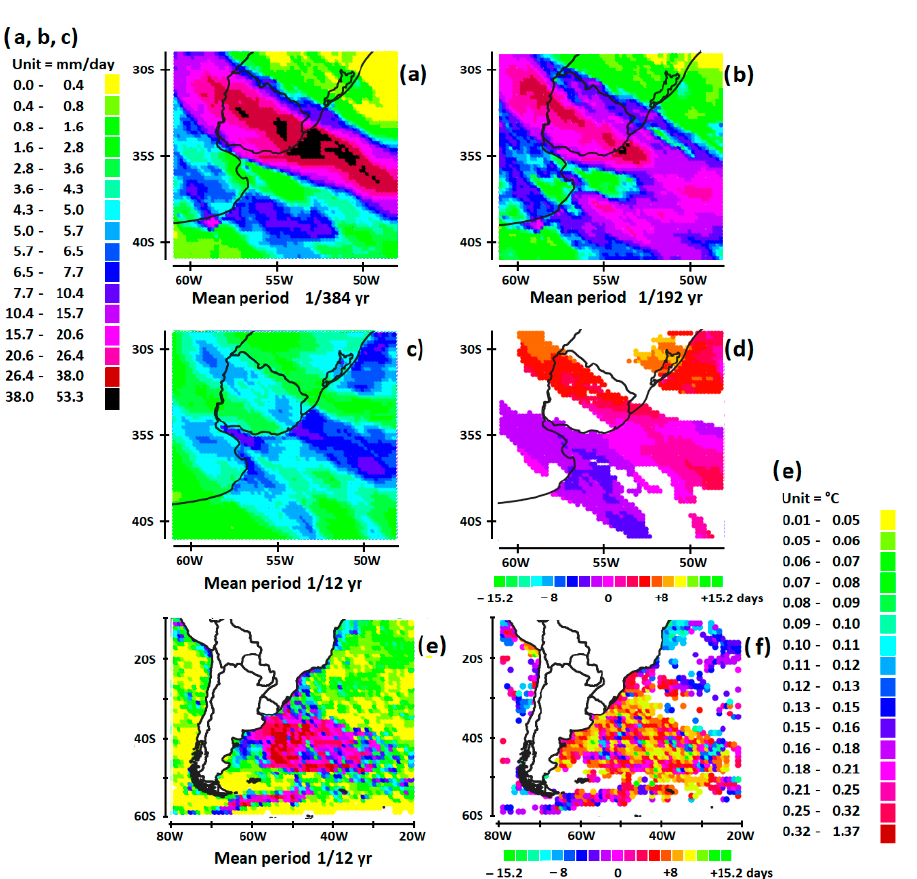
Figure 10. Extreme rainfall in Argentina. Same conventions as in Figure 7. Time lags in ( d , f ) are expressed in relation to 12 August 2015. The time reference is the rainfall depth at 34 ◦ S, 56 ◦ W. Co-Evolution of SST and Rainfall Anomalies in Characteristic Period Ranges SST anomalies between 0.32 and 1.37 ◦ C are located along the warm Brazil current of the South Atlantic gyre, after it collides with the northerly flowing cold-water Malvinas Current, a few days behind the ERE (Figure 10e,f). Homogenization of the thermocline depth occurs in tune with the 1/12 harmonic, as well as clustering of mesoscale lows (Figure